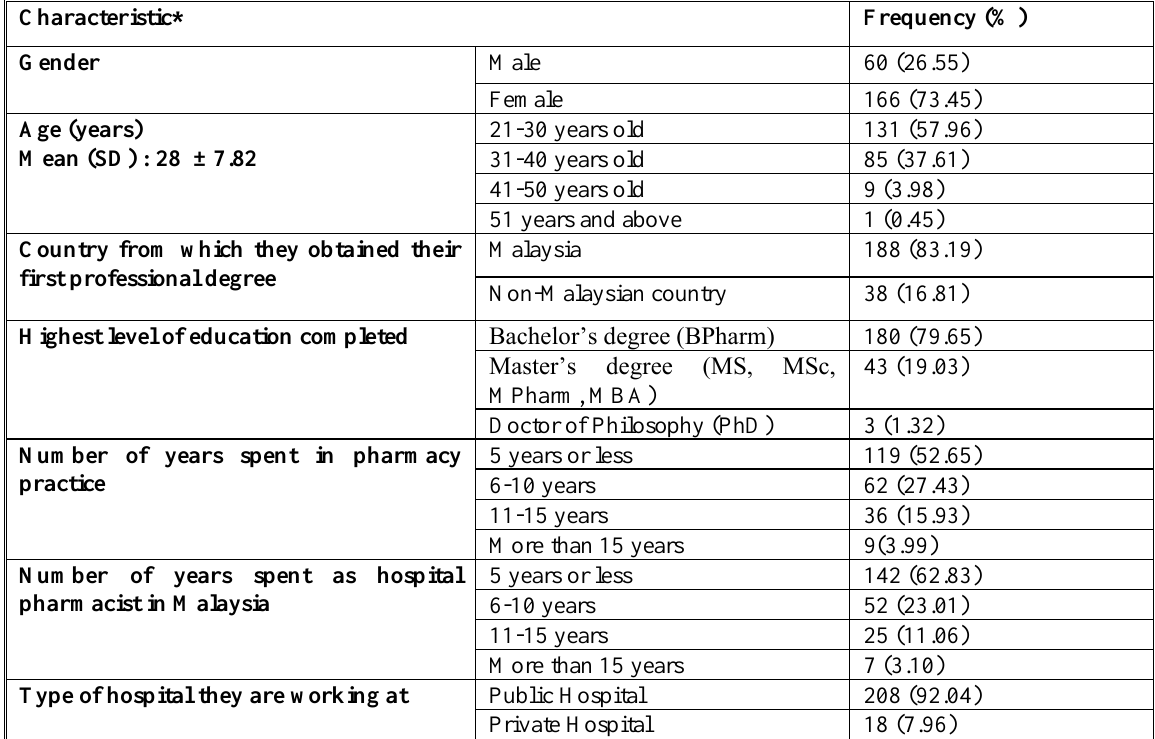
Table 1. Demographic and professional characteristics of Malaysian hospital pharmacists who responded to the survey (n = 226)